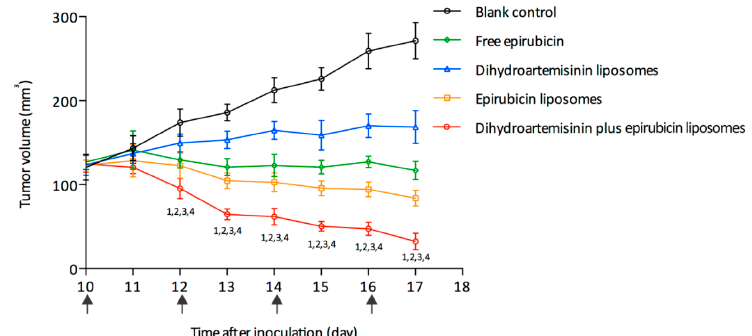
Figure 5. Antitumor efficacy in breast cancer MDA-MB-435S xenografts in nude mice. The arrows indicate the day of drug administration. Data are presented as the mean ± standard deviation ( n = 5). p < 0.05; 1, vs. blank control; 2, vs. free epirubicin; 3, vs. dihydroartemisinin liposomes; 4, vs. epirubicin liposomes.